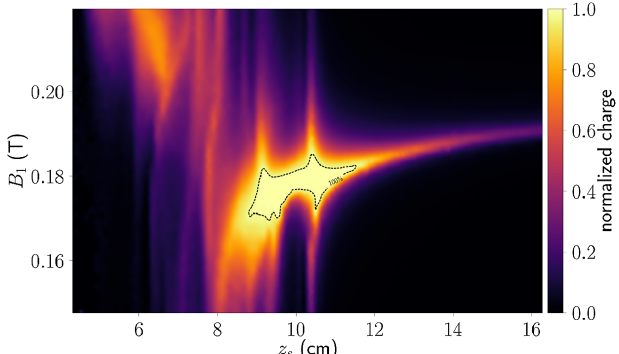
FIG. 3. Charge fractional transmission through the structure as a function B 1 and z s for injection parameters ð E i ; E z Þ ¼ ð 205 keV ; 105 . 8 MV = m Þ corresponding to a maximum bunch compression point from Fig. 2(c). A black dashed line encom- passes 100%